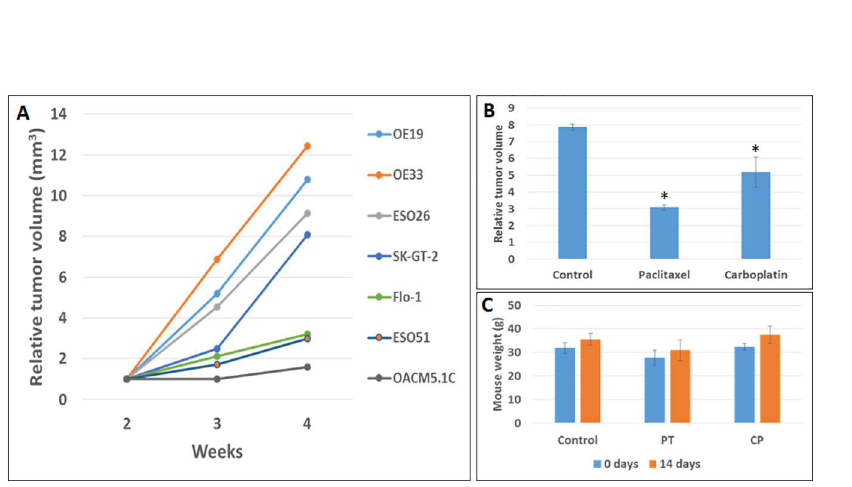
Fig 5. Study of subcutaneous tumor growth with changes of relative local tumor volume (RTV) and mouse weight after paclitaxel and carboplatin treatments in the OE19 subcutaneous mouse model. (A) Relativetumor volumesover a periodof 4 weeks after subcutaneous injectionof 5X10 6 cells of seven esophageal adenocarcinoma cell lines. Enhancedrelativetumor volumes were observedin OE33, OE19, ESO26 and SK-GT-2 cell lines. (B) RTV changes after paclitaxeland carboplatintreatments comparedto control (vehicle) in OE19 subcutaneous mouse model. * indicatesp < 0.05versus control. (C) No significant body weight changewas observedafter paclitaxeland carboplatintreatments comparedto control in the OE19 subcutaneous mouse model.